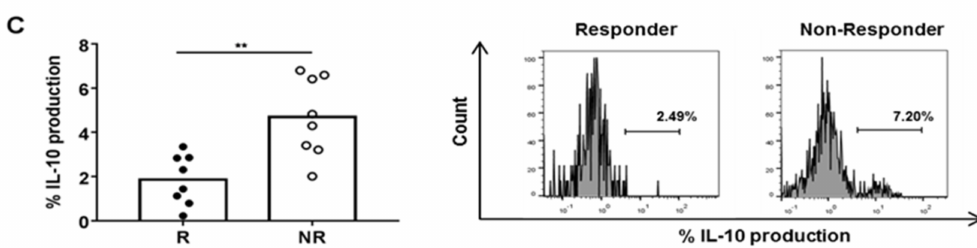
Figure 3. Cytokine production in CD8+ HLA-DR+ T cells after a 72 h-culture of HD PBMCs with 25% plasma from R ( n = 8) and NR ( n = 8) BC patients. Percentage of CD8+ HLA-DR+ T cells with intracellular ( A )IFN- γ , ( B )TNF- α ( C ) and IL-10 and respective histogram representation. ** p < 0.01; *** p < 0.001.